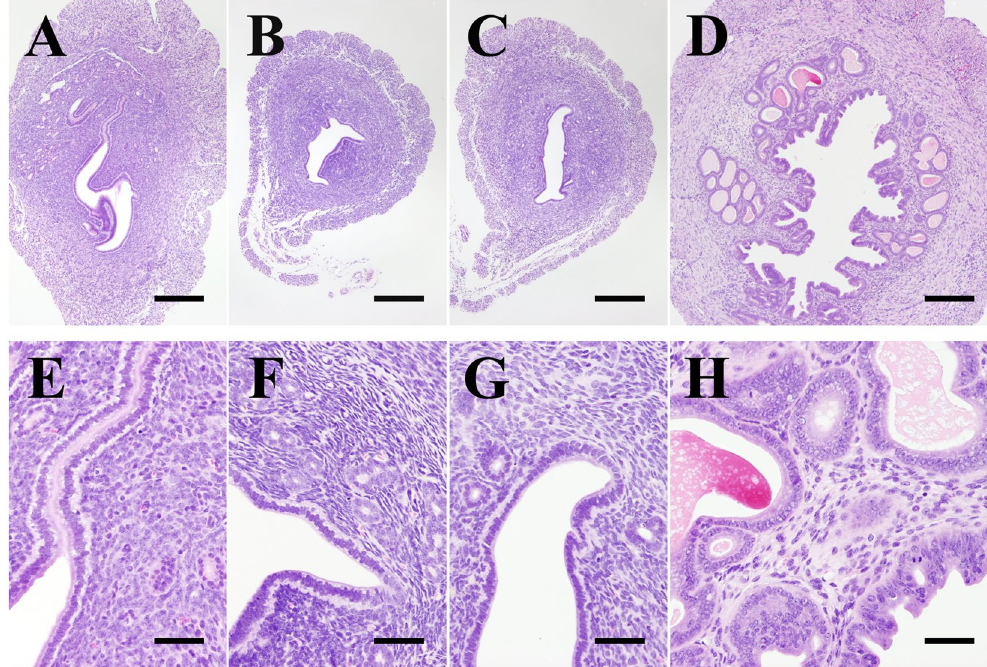
Figure 4. Uteri of a sham-operated mouse and OVX mice administered placebo, C-1, or E2. Uteri of a sham-operated mouse ( A , E ) and mice administered placebo ( B , F ), C-1 ( C , G ), or E2 ( D , H ) are shown. The endometrium and myometrium were atrophic in mice administered placebo or C-1. However, the endometrium and myometrium in mice administered E2 were thickened, with increased number and size of endometrial glands, and were dilated and filled with eosinophilic mucus. Scale bars = 500 µ m ( A , B , C , D ) and 100 µ m ( E , F , G , H ).